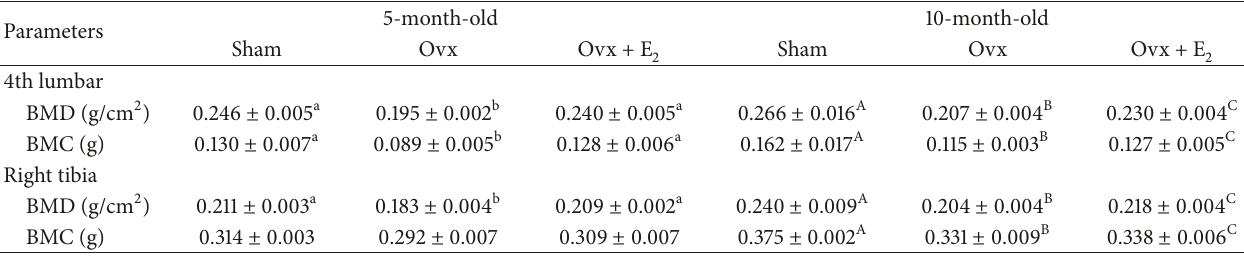
Table 3: The effects of ovariectomy (ovx) and 17 𝛽 -estradiol (ovx + E 2 ) on bone mineral density and bone mineral content of the 4th lumbar and right tibia in rats with initial ages of five and ten months. The mean tibial and vertebral bone mineral density and bone mineral content of ovx rats were significantly lower in comparison with sham rats in both age groups and E 2 administration prevented the bone loss.